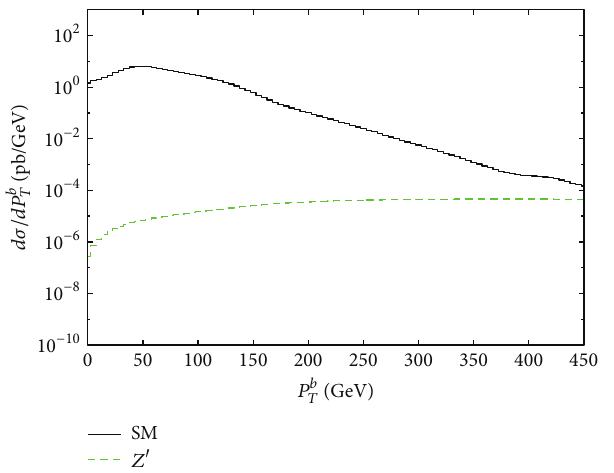
Figure 12: The transverse momentum ( 𝑝 𝑇 ) distribution of the bottom quarks ( 𝑏 and 𝑏 ) for the signal and background processes 𝑝𝑝 → (𝑊 + 𝑏𝑡 + 𝑊 − 𝑏𝑡) + 𝑋 at the LHC with √𝑠 = 13 TeV for the parameters explained in the text. These results are obtained for the 𝑍 󸀠 𝜂 model.